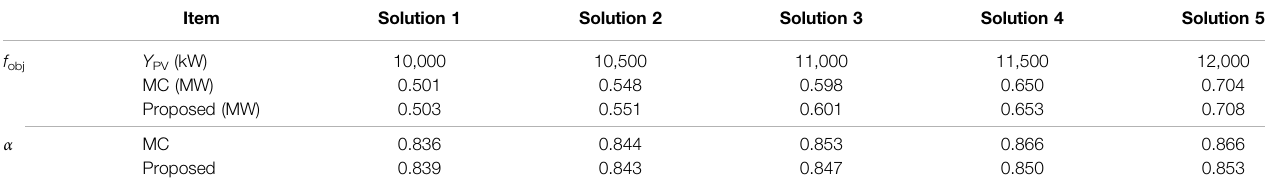
TABLE 2 | Input S imulation results for the O bjective and C onstraint functions.